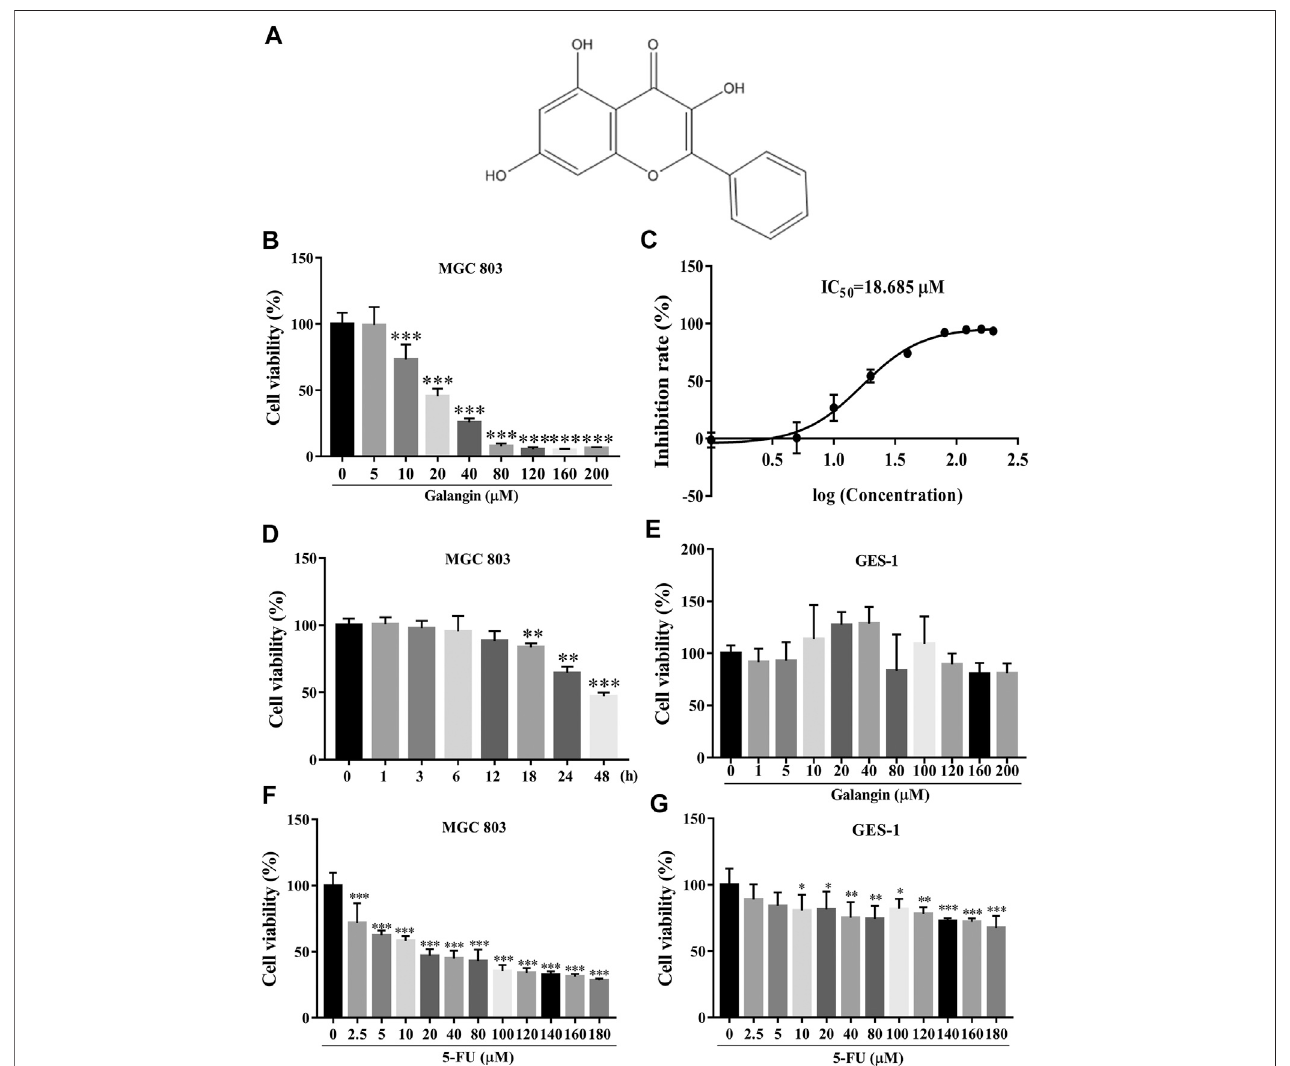
FIGURE 1 | Galangin inhibits cell viability of MGC 803 cells. (A) Chemical structure of Galangin. (B) Galangin reduced cell viability of MGC 803 cells in a dose- dependent manner after treatment for 48 h. (C) IC 50 of galangin for 48 h in MGC 803 cells. (D) Galangin (20 μ M) inhibited cell viability of MGC 803 cells in a time- dependent manner. (E) Galangin showed no signi fi cant effect on GES-1 cells (48 h), a normal gastric mucosal epithelial cell line. (F) 5-FU inhibited cell viability of MGC 803cells(48 h). (G) 5-FUinhibitedcellviabilityofGES-1cells(48 h).Allofthedatawereshownasmean ± SD,anddifferencesamong ≥ 3groups (Figures1B,D,E ) were analyzed via one-way ANOVA with Dunnett test by using GraphPad 7.0 software; * p < 0.05; ** p < 0.01; *** p < 0.001, compared with control group. n ≥ 3.